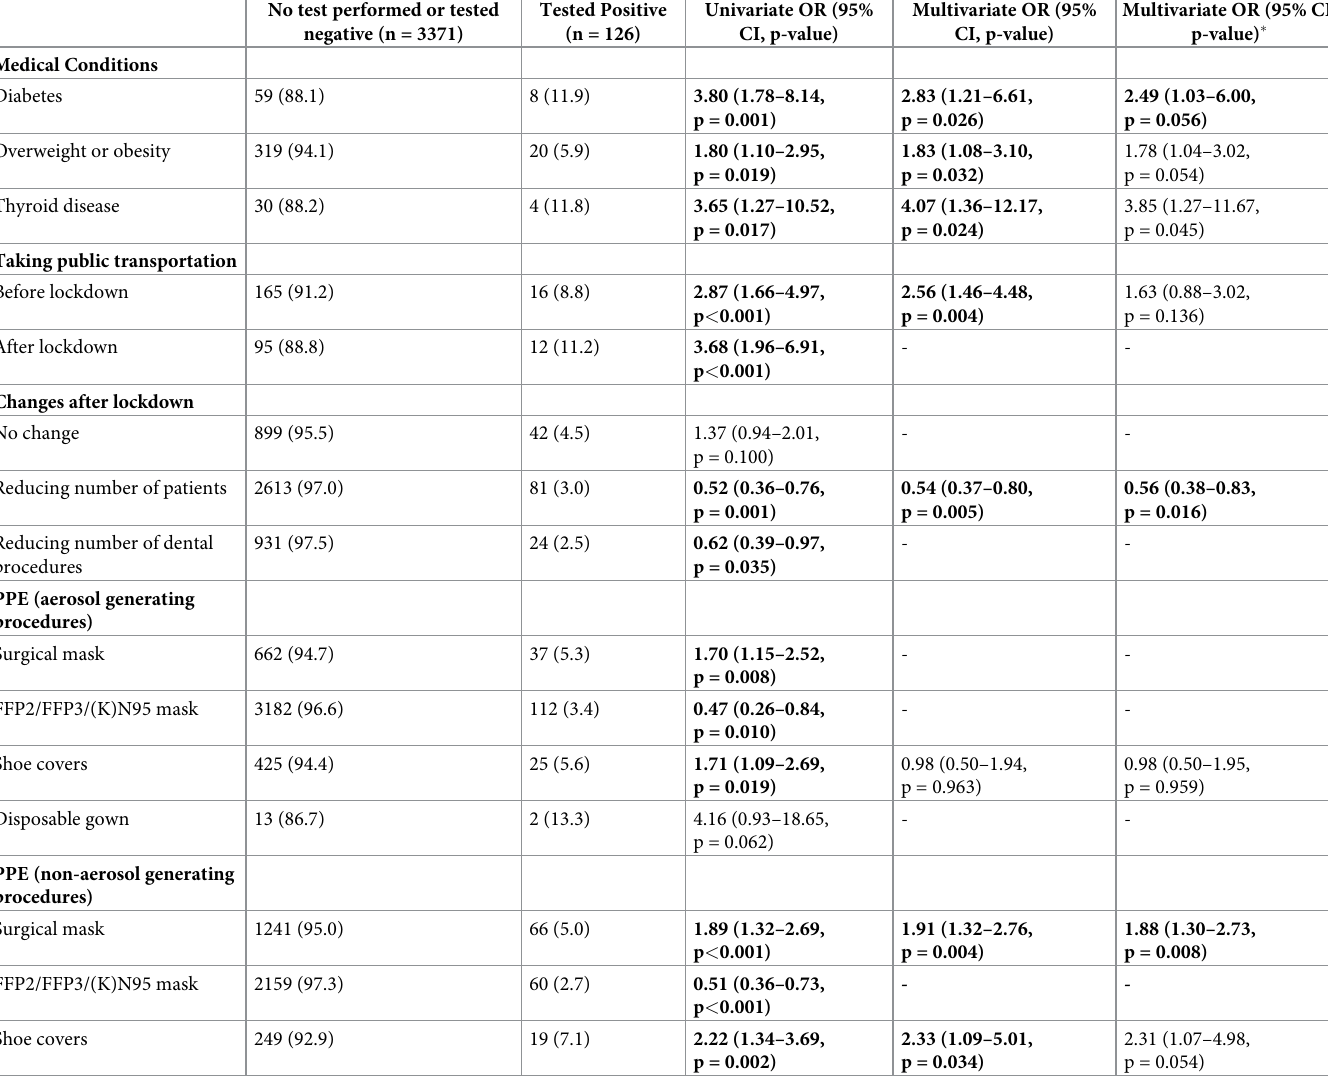
OR = odds ratio; 95% CI = 95% confident interval. PPE: personal protective equipment. � Multivariate analysis with random region